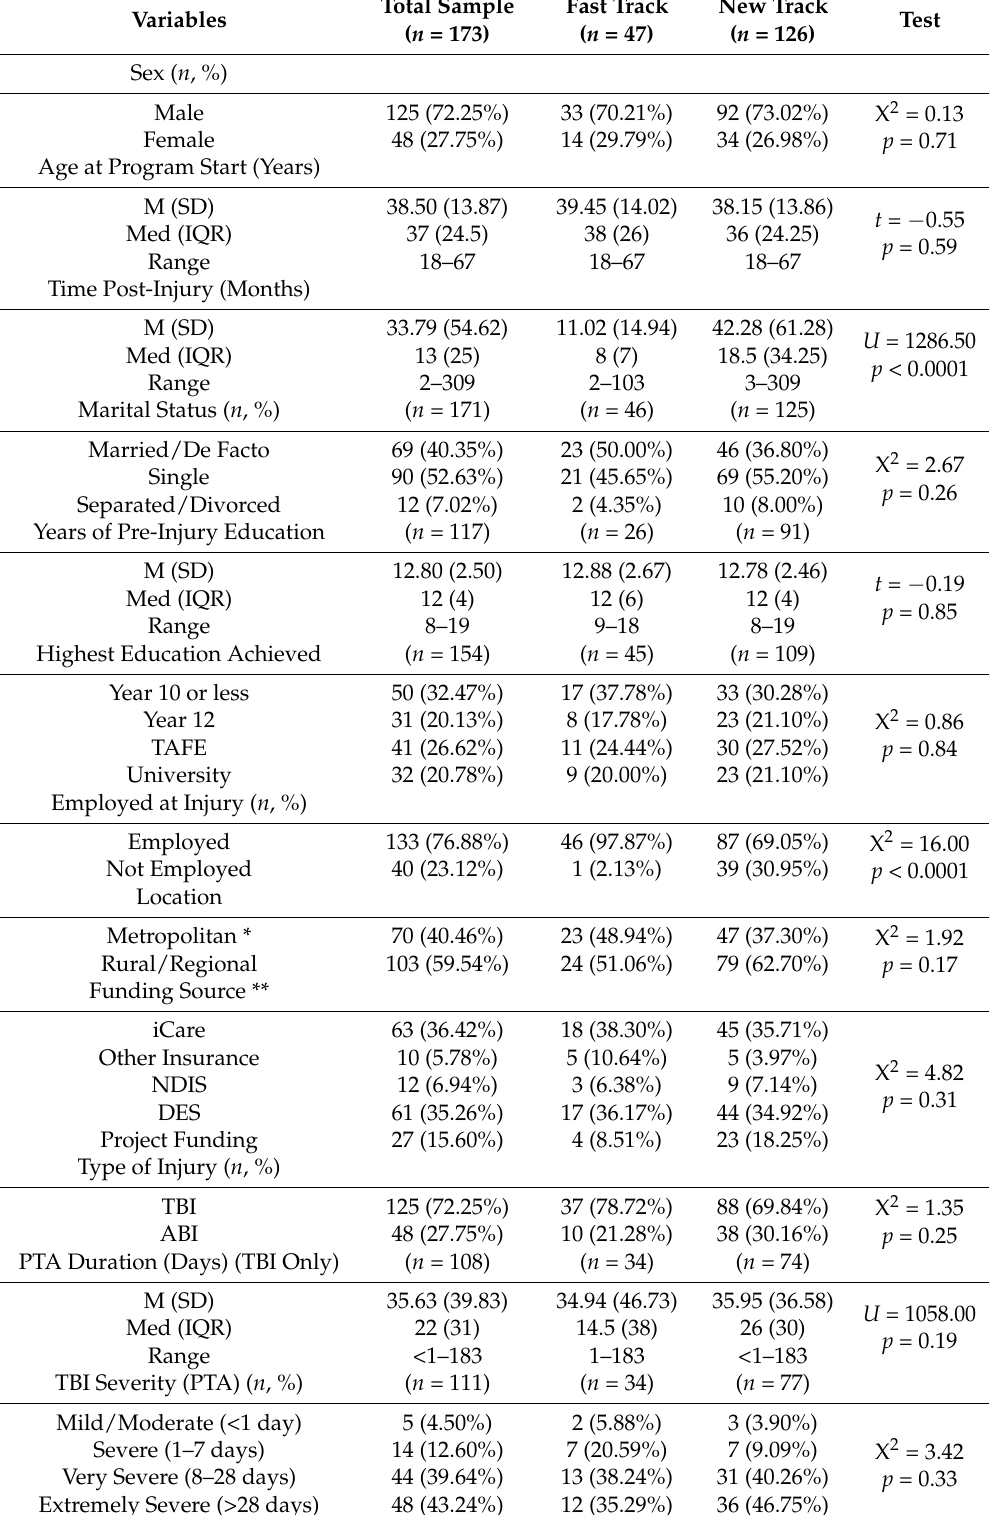
Table 3. Demographic, injury, psychosocial and employment details for clients commencing VIP